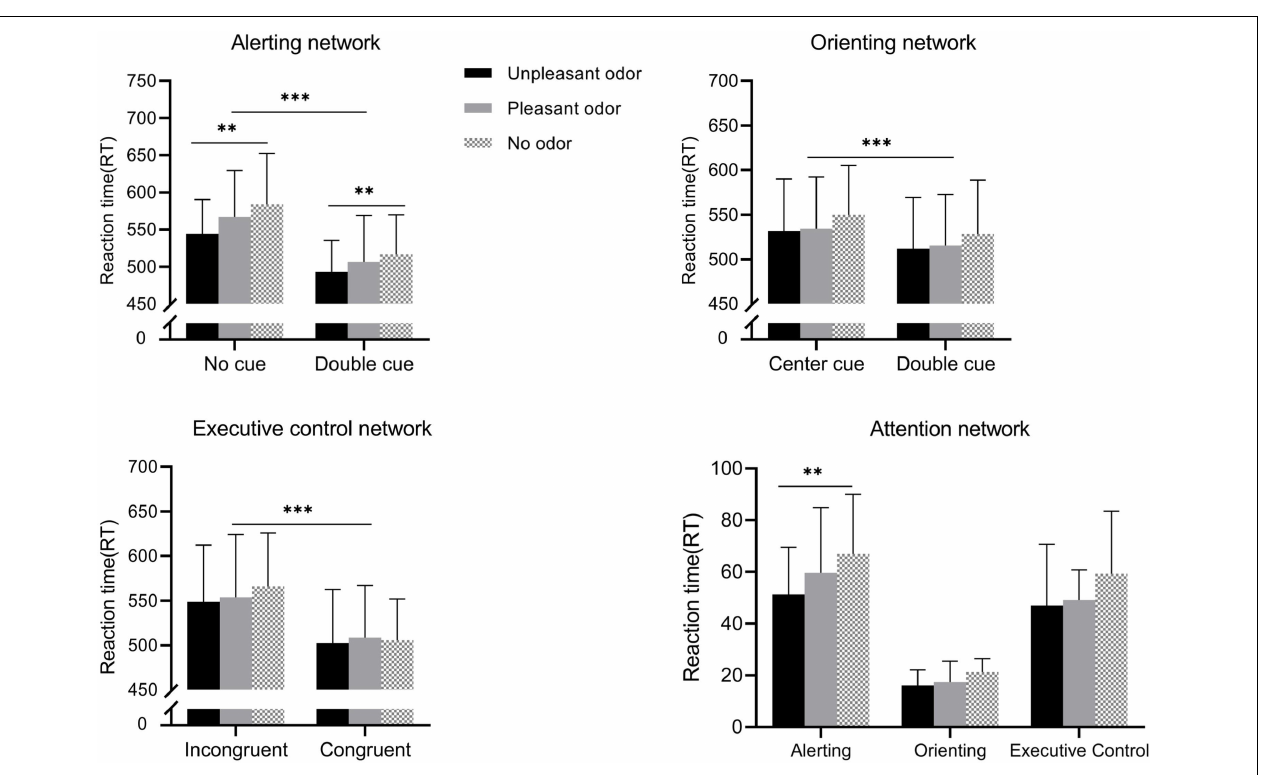
or interaction of effects was significant ( P -values > 0.05). The the cue and for the site conditions[cue: F ( 1 , 28 ) = 5.6, P = 0.02, η η 2 = 0.18; site: F ( 2 = 0.37]. The occipital site ( − 3.81 ± 0.8 µ V) showed target N1 amplitudes 1 , 28 ) = 15.3, P = 0.001, p p significantly larger than the parietal site ( − 2.38 ± 1.4 µ V). The interaction between cue and site was also significantly different double-cue condition ( − 3.56 ± 2.1 µ V) also had a [ F ( 1 , 28 ) = 4.46, P = 0.04, η p 2 = 0.15]. No other main effect